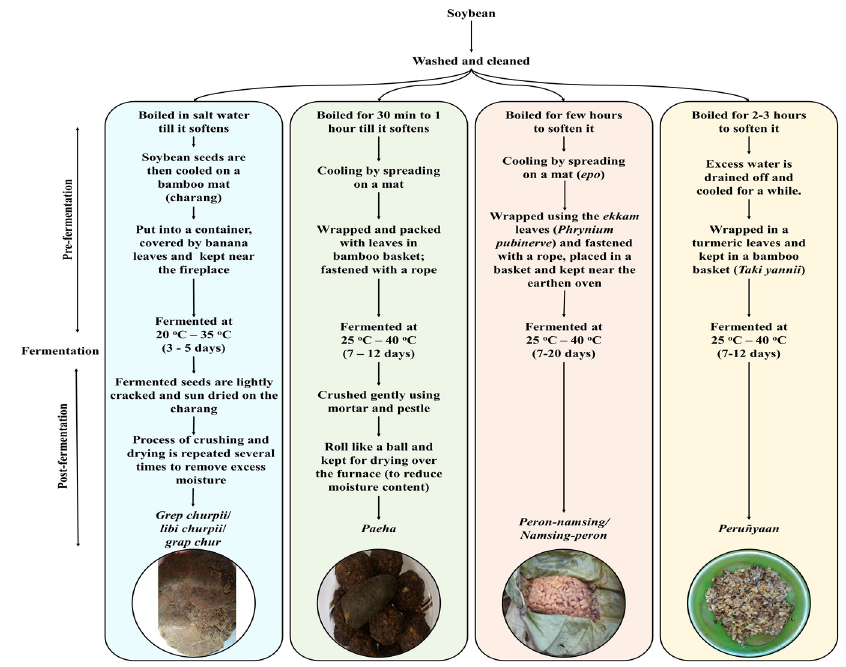
Figure 2. Traditional methods of preparation of the naturally fermented soybean products of Arunachal Pradesh, India: grep chhurpi, peha/paeha, peron naming, and peruñyaan .